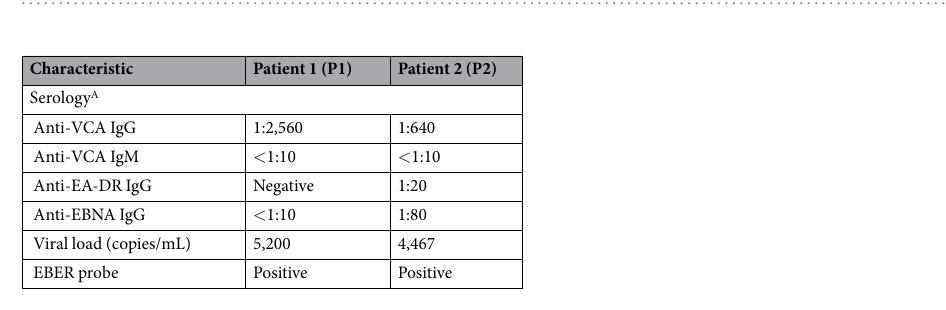
Table 1. Detection of EBV infection. A Antibody titers. VCA, viral capsid antigen; EA-DR, early antigen-diffuse and restricted; EBNA, EBV nuclear antigen; EBER, EBV-encoded